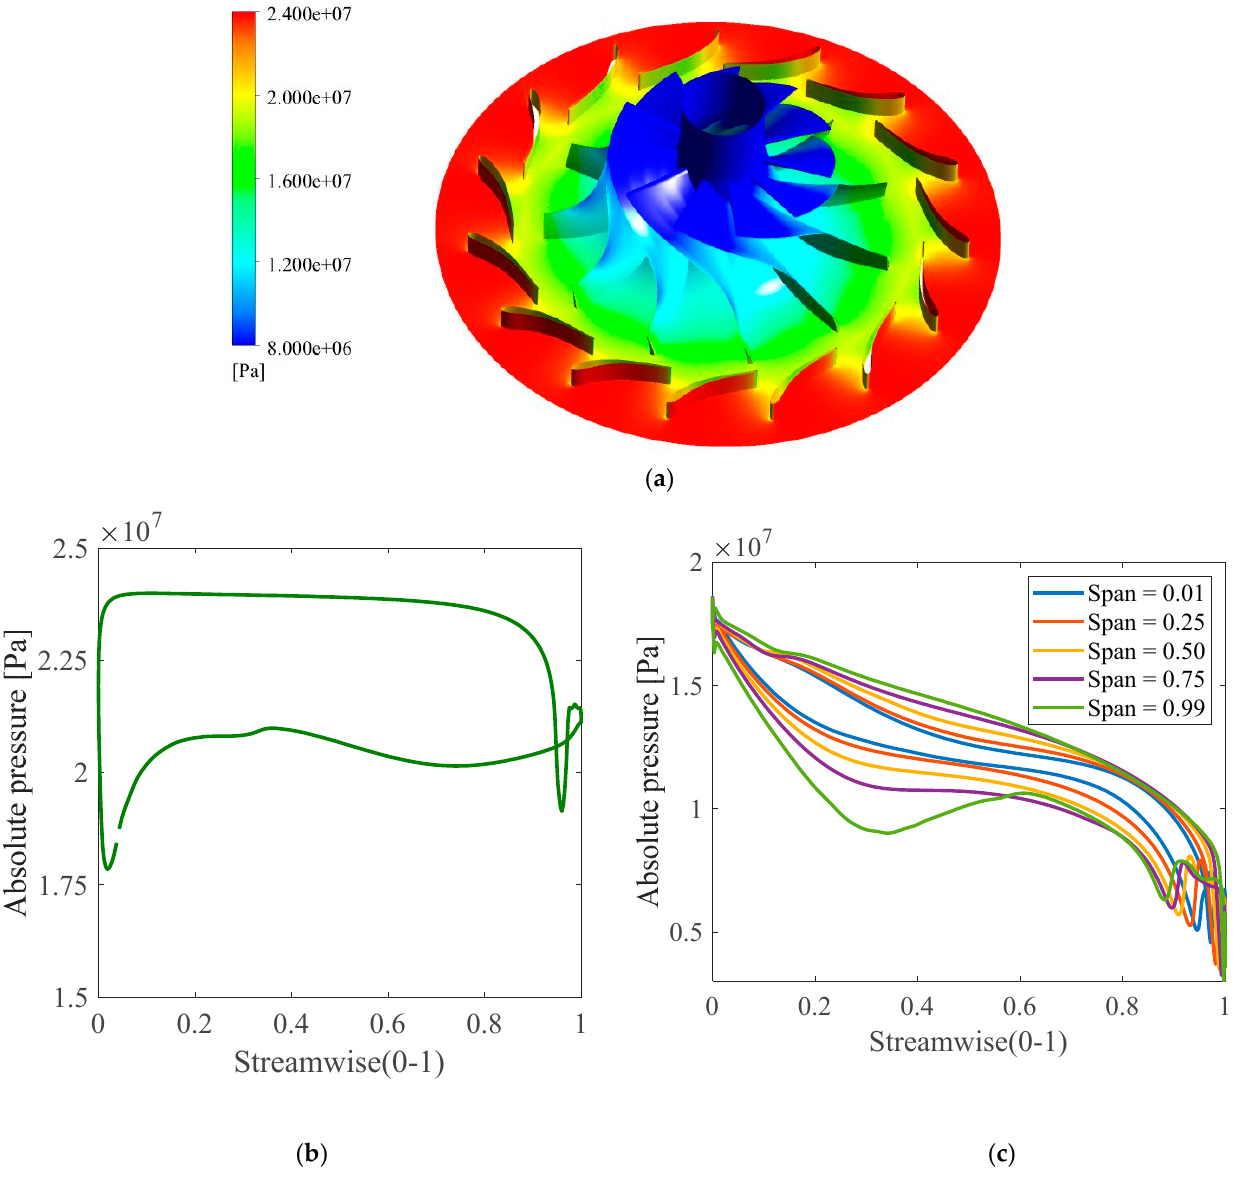
Figure 16. ( a ) Pressure contours on the hub and blades surfaces, ( b ) pressure profile along the nozzle guide vane at 50% span, and ( c ) pressure profiles at various points.